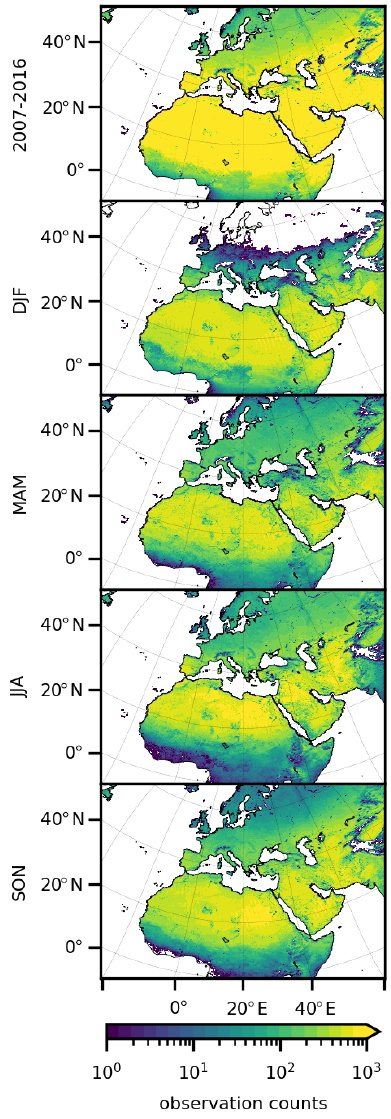
Figure 2. Maps of counts of assimilated observations for the whole period (2007–2016; top row) and for the different seasons (DJF, MAM, JJA, SON; rows 2 to 5) of the 10-year